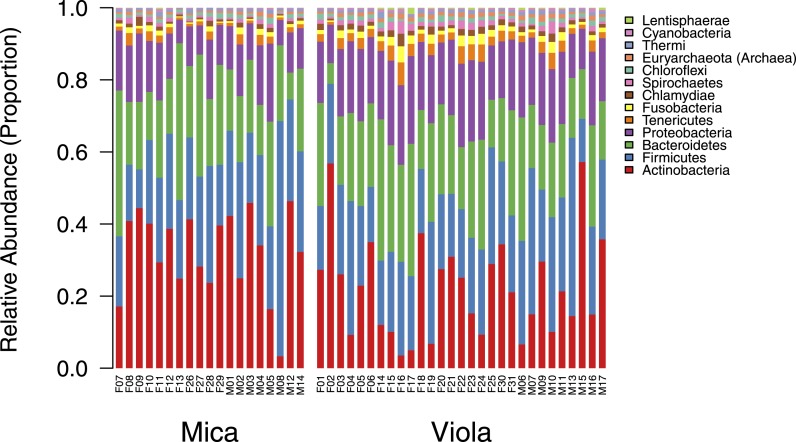
Proportional representation of common phyla in each sample.The OTU table generated using MetaPhlAn 2.0 was collapsed to the level of the phylum for each sample. Phyla that were not represented at ≥ 1% in at least one of sample are summed and presented as ‘rare phyla.’ Samples from Mica's group are clustered on the left and those from Viola's group on the right.